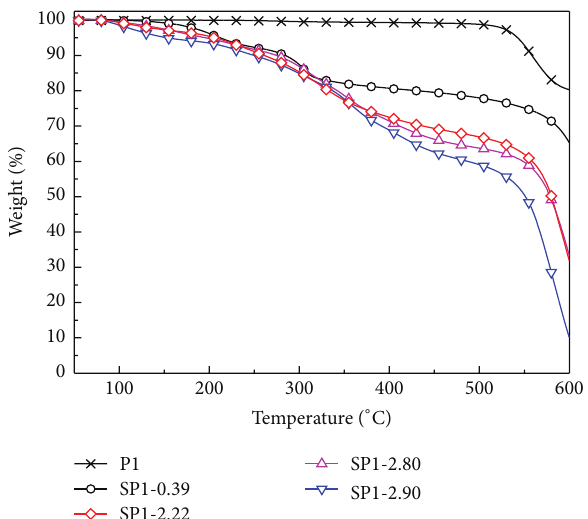
Figure 4: Hydration number as a function of temperature for SP1- 𝑋